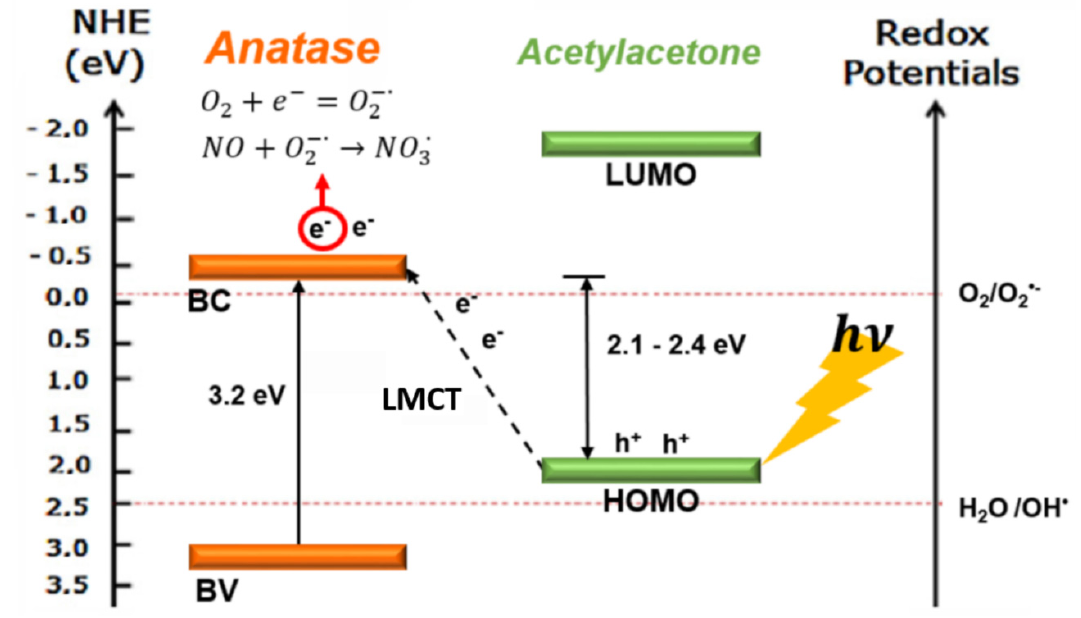
Figure 9. Scheme of electronic bands for the TiO 2 -ACAC CTC and, consequent, for NO x Scheme of electronic bands for the TiO 2 -ACAC CTC and, consequent, for NO x photooxidation reaction. photooxidation